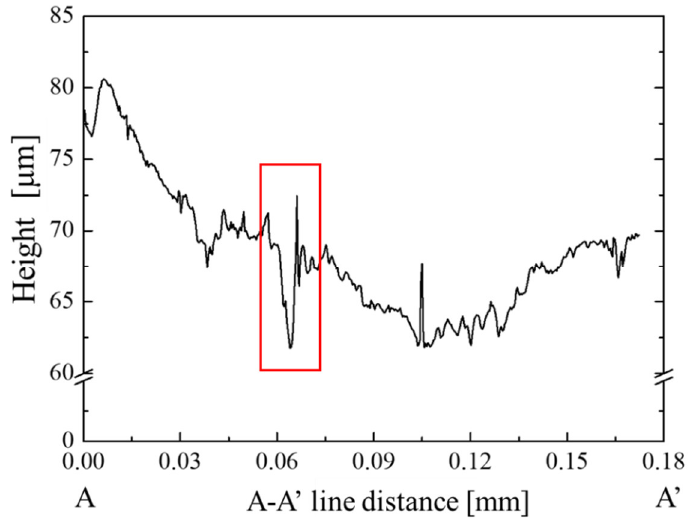
Figure 7. Cross-sectional shape of the “B” part of Figure 5 with the lines A-A′ in Figure 6.